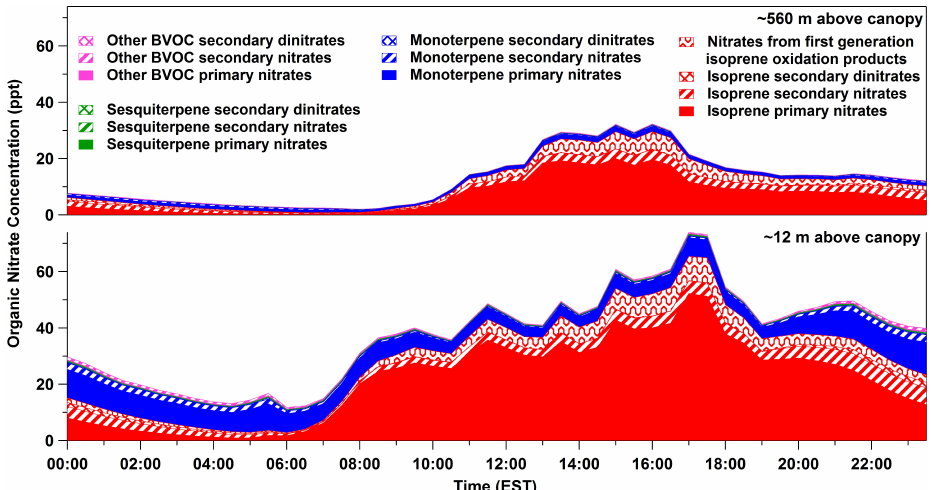
Fig. 3. Diurnal cycles of modeled organic nitrate concentrations at ∼ 560m and ∼ 12m above the forest canopy. Low total concentrations of sesquiterpene and other BVOC nitrates are shown for both heights, with concentrations ranging from 0.6ppt in the mid-day (12:30) to a maximum of 2.1ppt at 23:30 for ∼ 12m above the forest canopy, compared to 0.1–0.4ppt through the course of the day at ∼ 560m above the forest canopy. Results for the base BVOC production rate scenario are shown.